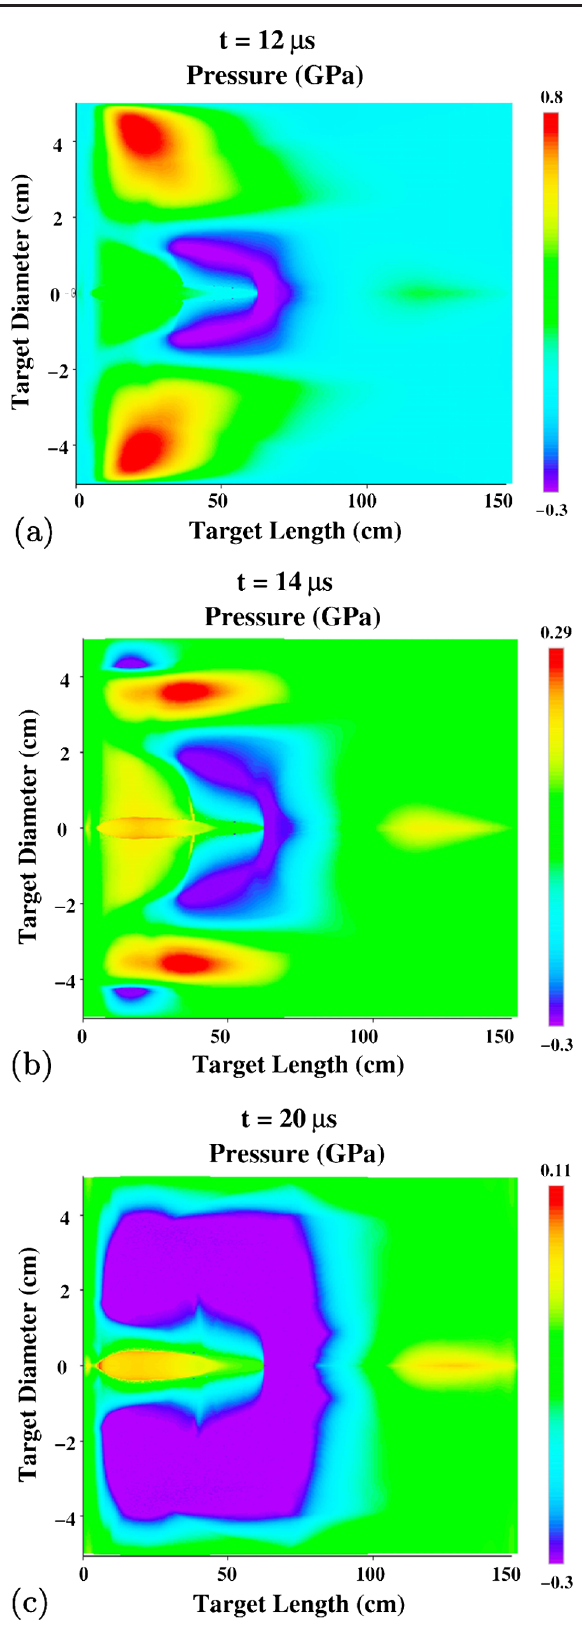
.FIG. 15. Pressure distribution corresponding to Fig.